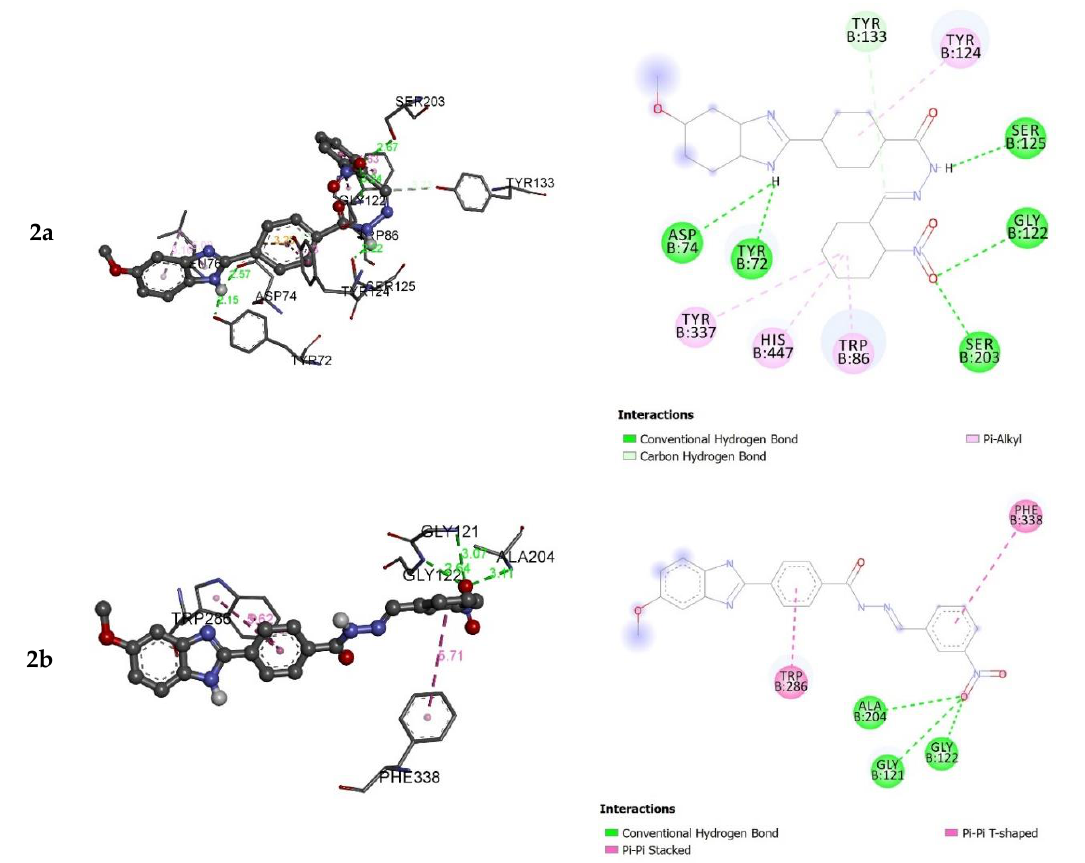
Figure 4. Three-dimensional ( right ) and two-dimensional ( left ) closest interactions between active site residues of acetylcholinesterase and benzimidazole Schiff bases 2a and 2b .